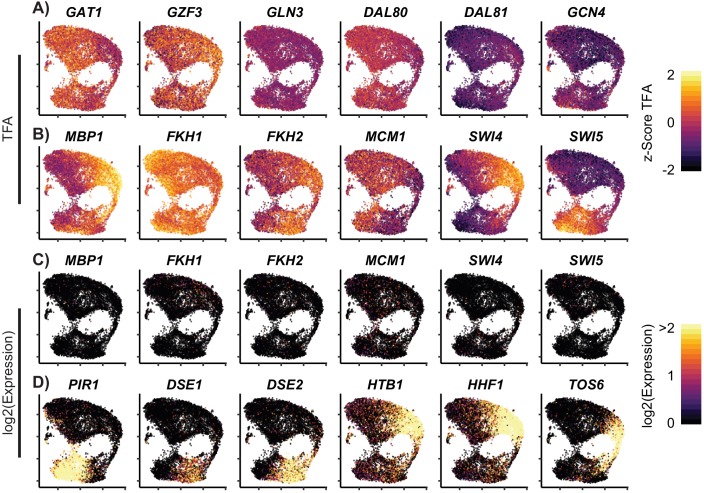
Cell Cycle TF Activity Clusters within Growth Conditions.Cells grown in YPD are plotted after UMAP with (A–B) z-Score of the calculated transcription factor activity (TFA) based on the learned network for (A) select nitrogen TFs and (B) cell cycle TFs (C) Log2 of the expression of cell cycle TFs (D) Log2 of the expression of cell cycle target genes.